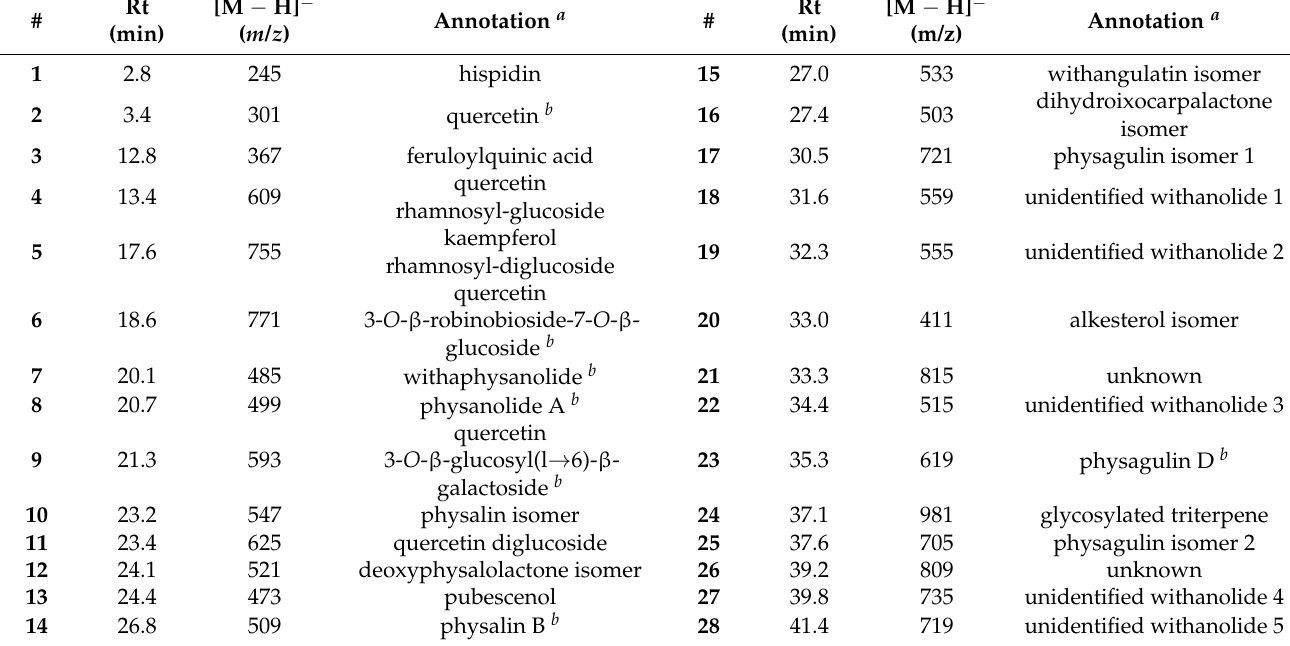
Table A2. Annotation of most contrasting metabolites based on VIP > 1 after PLS-DA